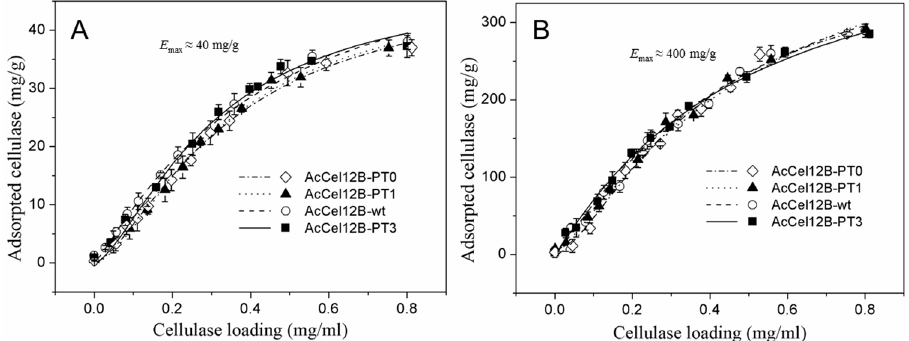
Figure 4. Adsorption of AcCel12B and its mutants on Avicel ( A ) and RAC ( B ). All the figures were described as AcCel12B ‐ PT0 (dashed dotted line and ◊ ), AcCel12B ‐ PT1 (dotted line and ▲ ), AcCel12B ‐ wt (dashed line and ○ ), and AcCel12B ‐ PT3 (solid line and ■ ).